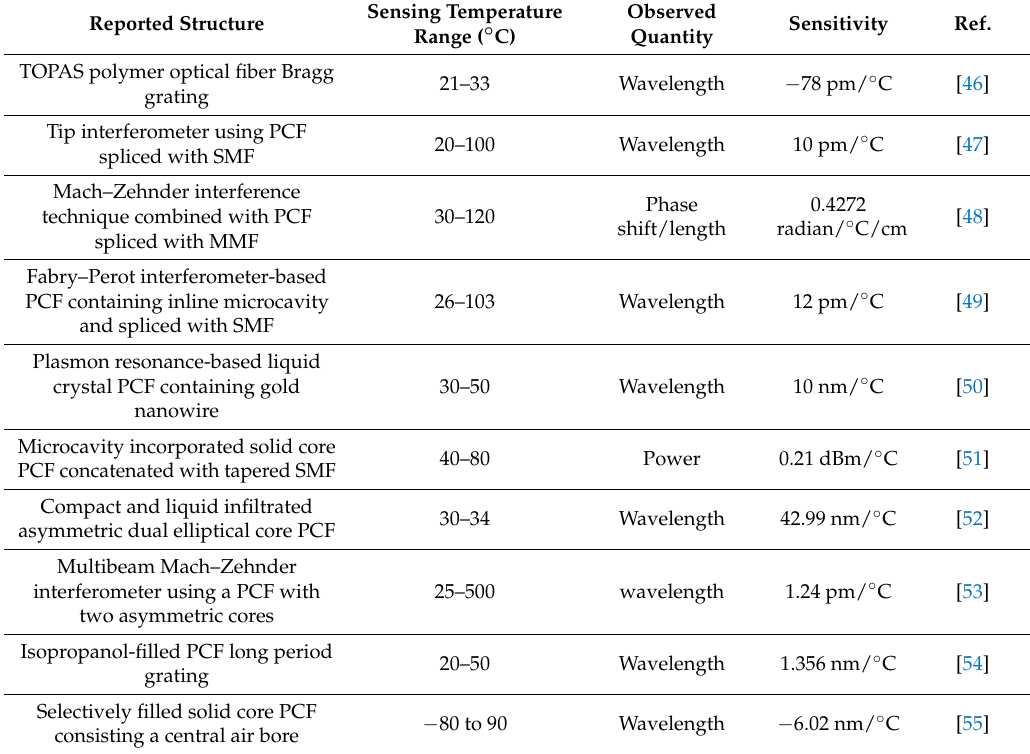
Figure 9. Cross-section of the proposed nanoscale gold layer incorporated PCF for temperature sensing (Reproduced from [31], with the permission of IOP Science publishing). Table 1. Comparative representation of different PCF-based temperature sensor.